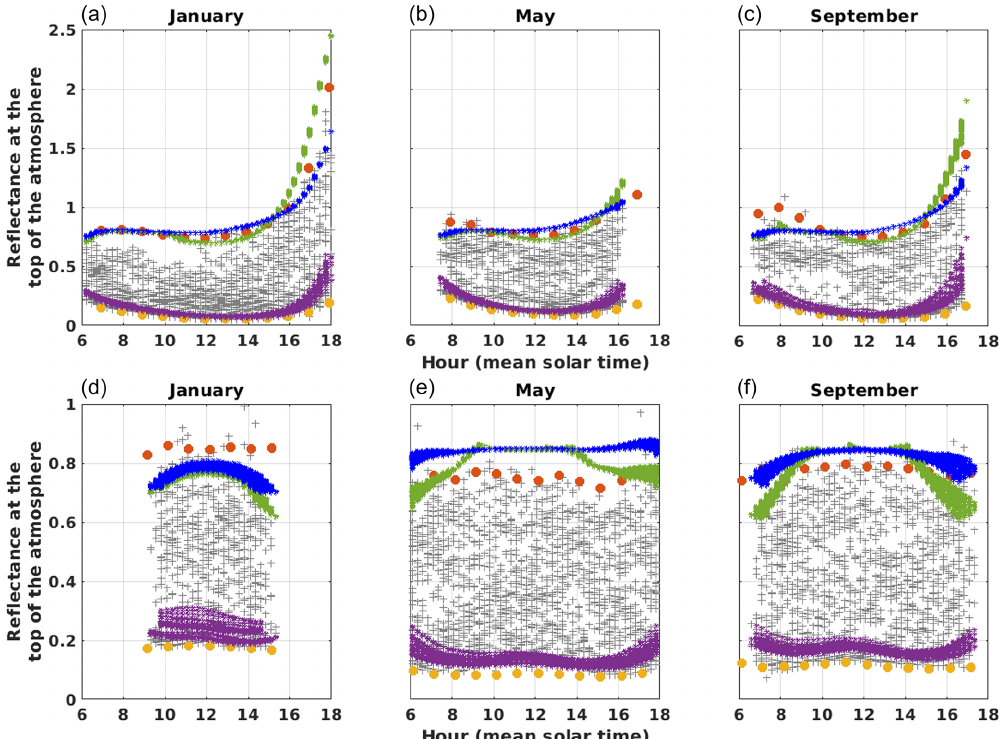
Figure 7. Simulated and measured reflectances at the top of the atmosphere above the São Martinho da Serra (Brazil, a–c ) and Camborne (United Kingdom, d–f ) locations, for the MSG 0.6µm channel and for the January, May, and September calendar months. Gray plus signs: MSG measurements (2011, Meteosat-9). Green asterisks: reflectances in overcast conditions ρ ovc , derived from the liquid cloud look-up table. Blue asterisks: same from the ice-cloud look-up table. Purple asterisks: reflectances in clear-sky conditions ρ clear , derived from radiative transfer simulations. Yellow and orange dots are, respectively, hourly percentiles 1 and 99 of MSG satellite measurements from years 2011 to 2019.